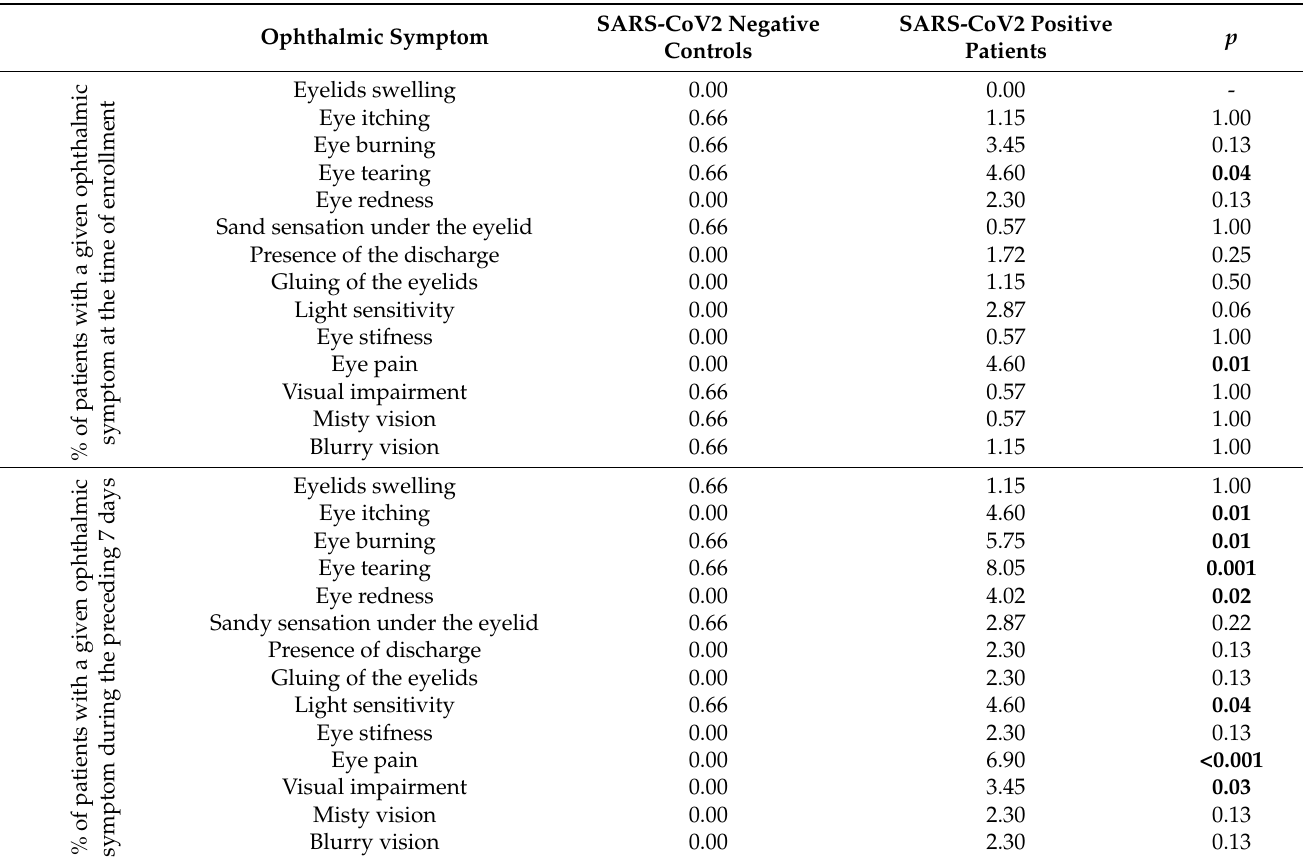
Table 2. Ophthalmological characteristics of patients with positive and negative SARS-CoV-2 PCR results. Statistically significant p values are shown in bold. SARS-CoV2 Negative SARS-CoV2 Positive p Ophthalmic Symptom Controls Patients